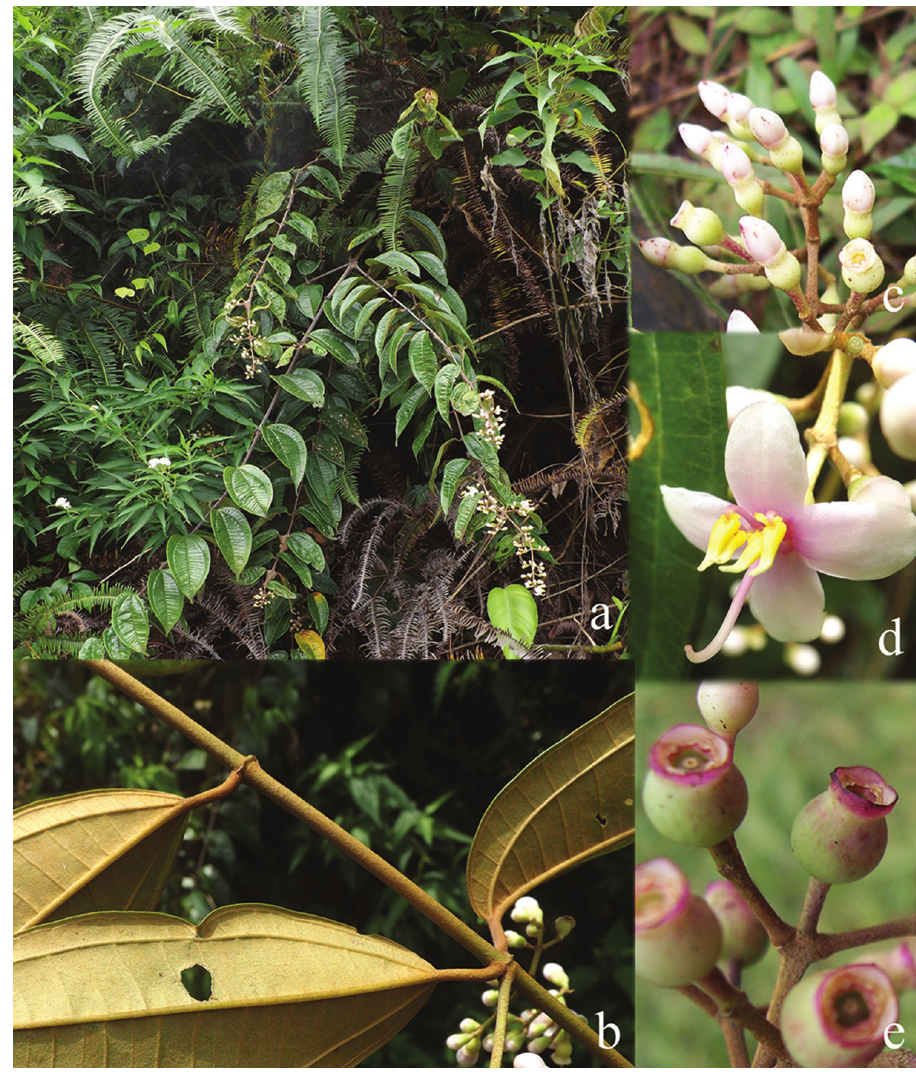
Figure 19. Dissochaeta inappendiculata a habit b branchlet c hypanthium d flower e fruits. Photographs by A. Kartonegoro; vouchers: Kartonegoro 1104 (BO, L). petalous (less than ⅓ of the alternipetalous ones) have a distinct spuriform crest (Kar- tonegoro and Veldkamp